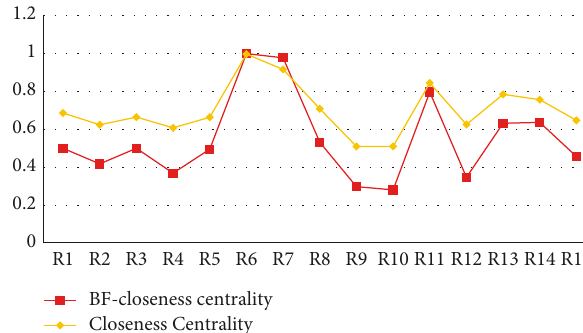
Figure 5: Scattered chart marked with lines depending on BF-degree and degree centrality measures (normalized) on G-S Research